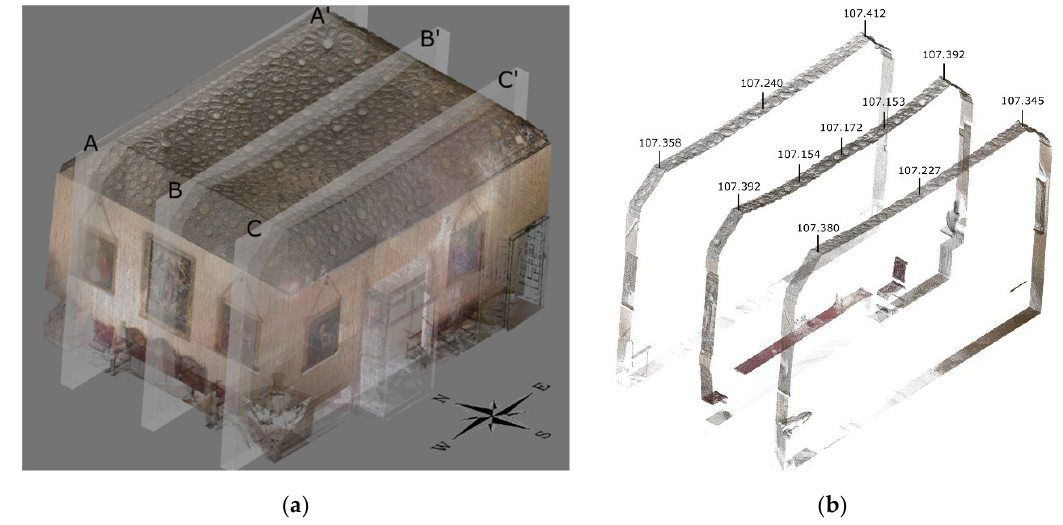
Figure 17. Mezzanine sections: ( a ) Sections AA′, BB′, CC′. ( b ) Heights in sections AA′, BB′, CC′. The measurement data is unexpected, since it would be logical to find the greatest deformation in the ceiling centre. However, when observing section BB′ or its orthogonal view (Figure 18), it is verified that the greatest height differences are found 1.05 m from the centre of the room with height differences of 0.238 m from B and 0.239 m from B′. The difference in height from both B and B′ to the centre is 0.220 m. Therefore, between the lowest point of the ceiling and the centre there is a height difference of 0.018 m. These results are coherent with the existence of anchors placed in the 1968 consolidation work directed by Goméz-Millán to alleviate the stresses derived from its own weight.